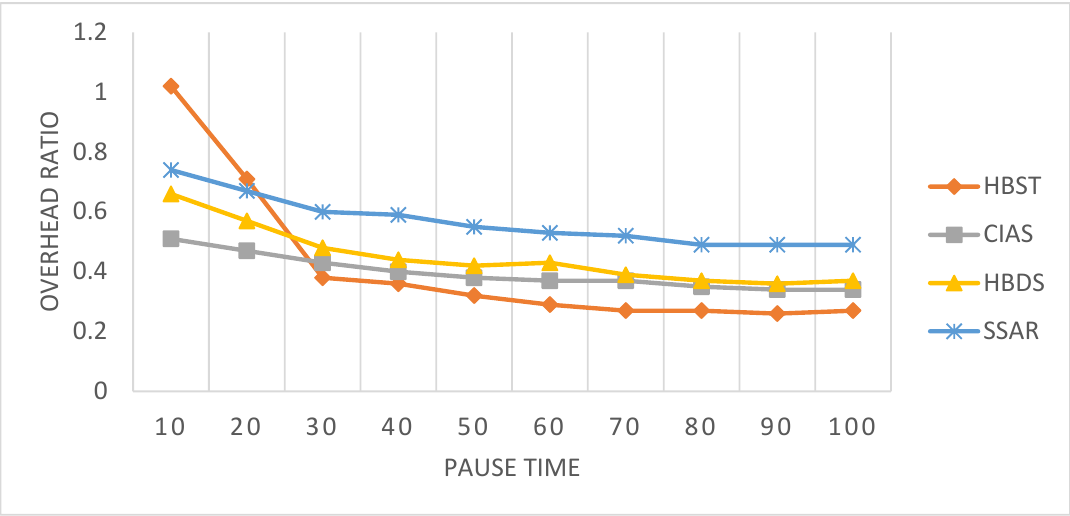
Figure 3. Routing overhead ratio for the network having 25% selfish nodes.